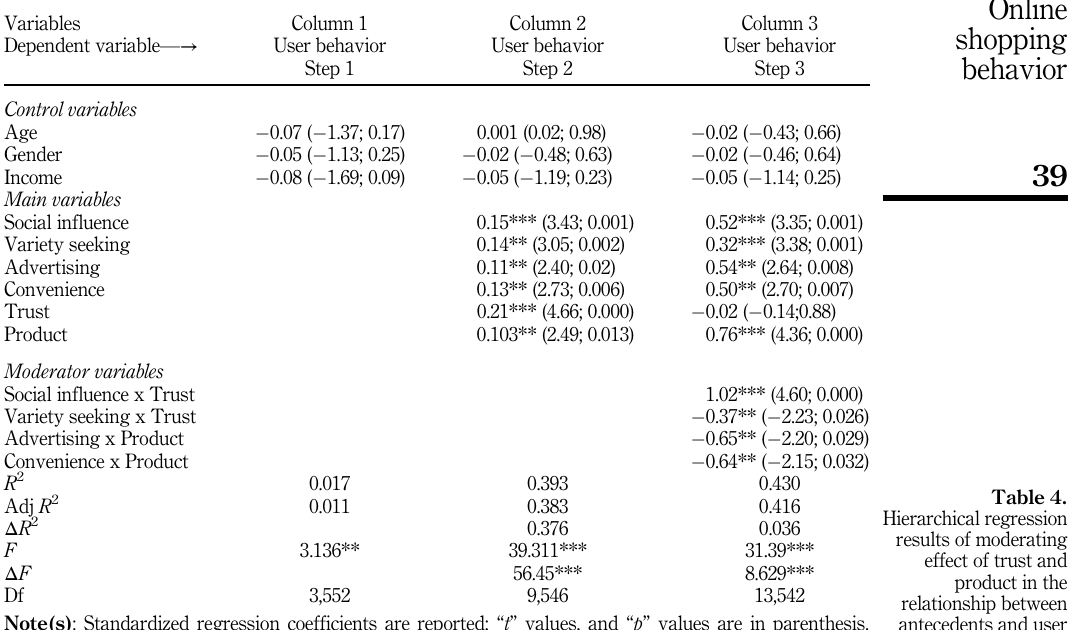
Table 4. Hierarchical regression results of moderating effect of trust and product in the relationship between antecedents and user